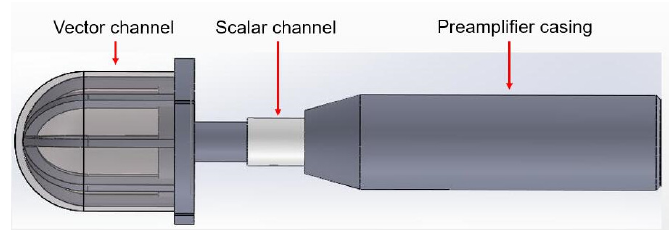
Figure 4. Schematic diagram of the composite hydrophone.